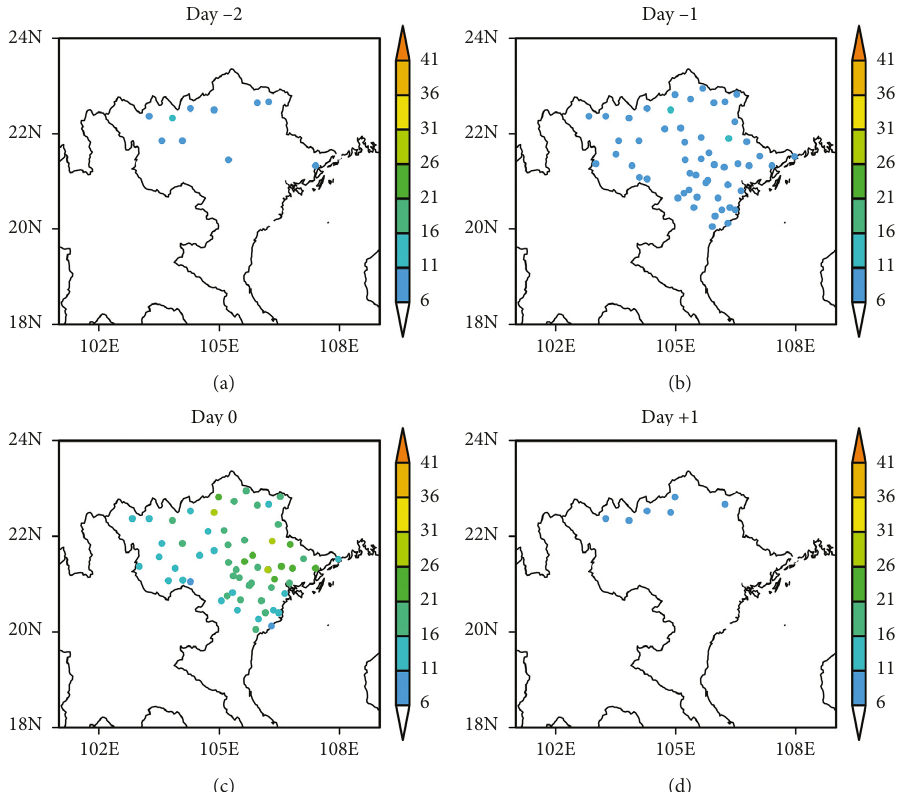
Figure 9: Same as Fig. 4, except for during the events associated with cold surge and upper-level trough.